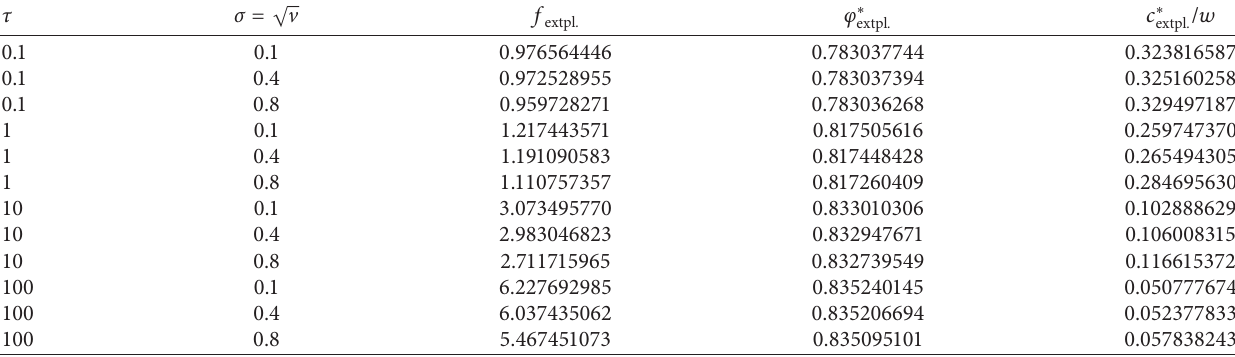
Table 11: Numerical solutions for f, φ ∗ , and c ∗ / w after performing Richardson’s extrapolation. Here, α � 0 . 1 and Δ τ � Δ v � 0 . 001. Other parameter values are the same as those in Table 1.